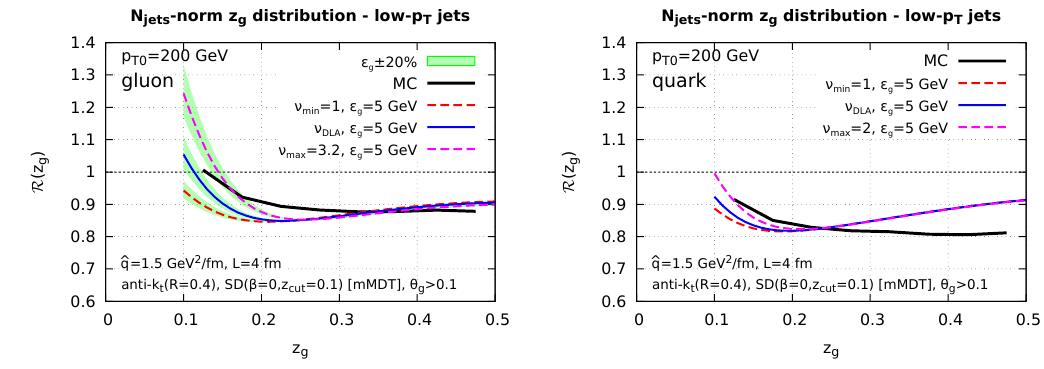
Figure 17 . R ( z g ) for a leading parton (left: gluon, right: quark) with initial transverse momentum p T 0 = 200 GeV. The Monte Carlo results are compared to analytic calculations corresponding to 3 di(cid:11)erent approximations for the number (cid:23) of sources emitting MIEs (see the text for details).